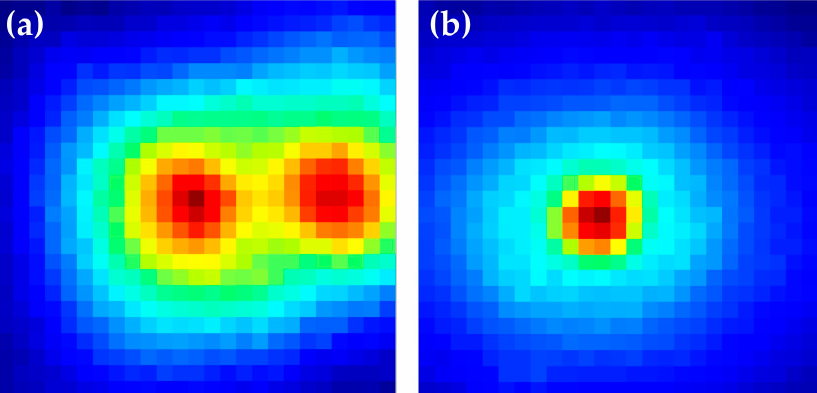
Figure 11. Acoustic maps of sources of pink noise recorded in outdoor conditions. ( a ) Two sources 3 m apart, 15 m away from the AC; ( b ) a single source in the middle of the field of view of the AC.